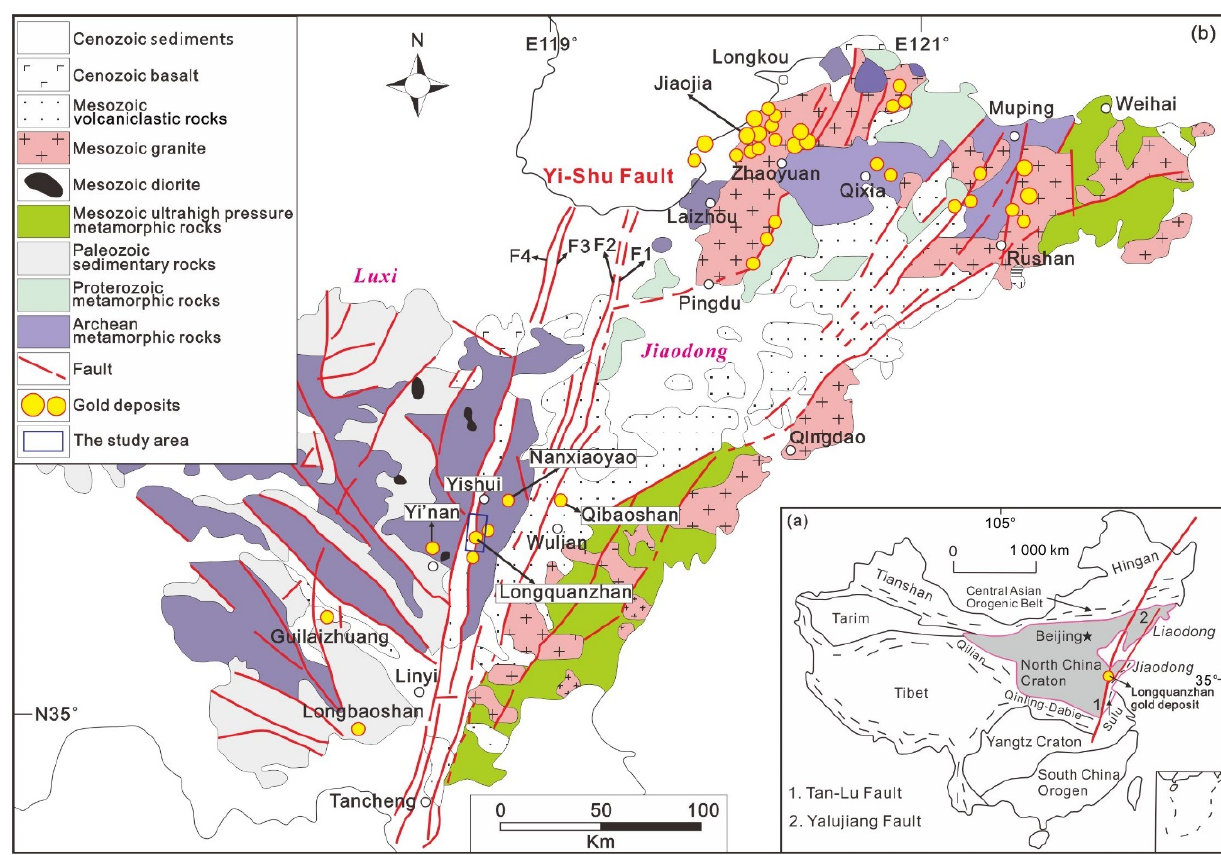
Figure 1. ( a ) Tectonic map illustrating the major tectonic divisions of China (modified from [14]); ( b ) Geological map showing the geology and major deposits of the Shandong Province (modified from [4]). F1: Changyi-Dadian fault, F2: Anqiu-Juxian fault, F3: Yishui-Tangtou fault, F4: Tangwu-Gegou fault.